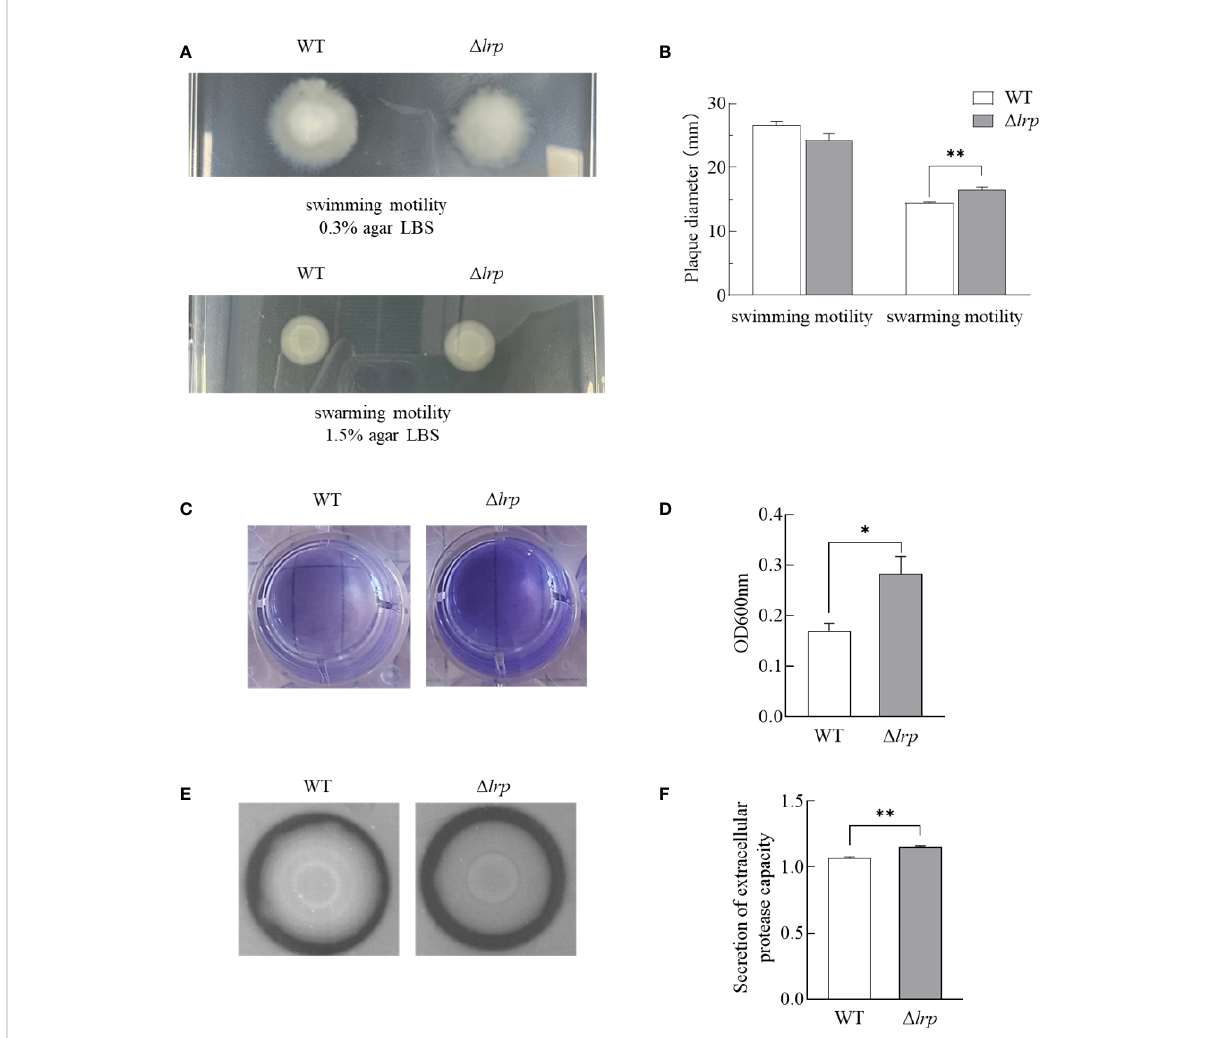
FIGURE 4 Motility, bio fi lm formation and extracellular protease secretion activity of WT and D lrp strains. (A) : the growth of the strains on the 0.3% and 1.5% agar LBS plate; (B) : the colony diameter statistical analysis; (C) : dissolved crystal violet-stained bio fi lm; (D) : the absorbance value of bio fi lm staining; (E) : strains growth on the skim milk plate; (F) : graph of extracellular protease secretion capacity, vertical coordinate is the ratio of outer circle diameter to inner circle diameter. (**, P <0.01; *, P